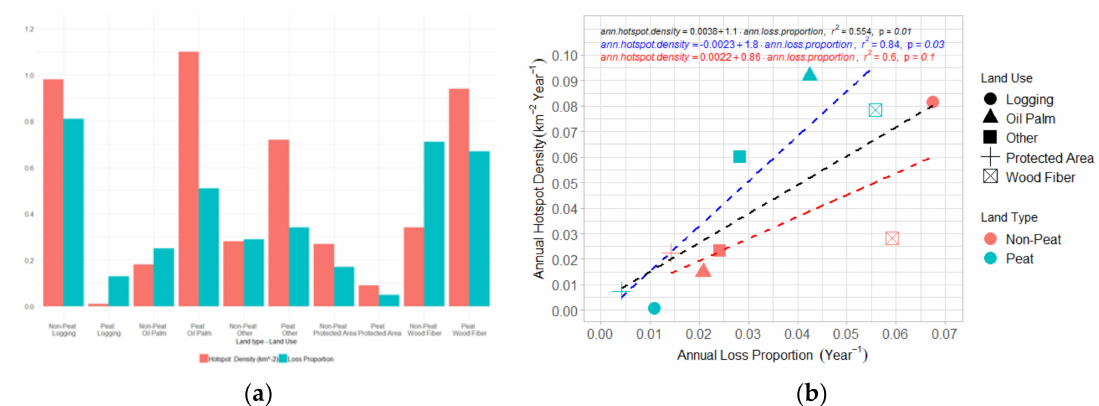
Figure 6. Comparison of forest loss rates and hotspot density across di ff erent land-uses. ( a ) Proportional forest loss (green) and hotspot density (red, km − 2 ); ( b ) Correlation between annual proportional forest loss and annual hotspot density. Dashed lines show regression lines for peat (blue), non-peat (red) and both